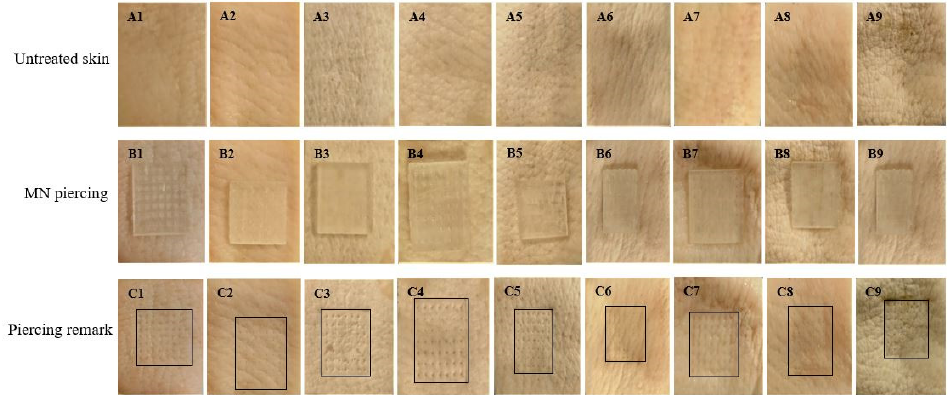
Figure 5. Digital photographs showing ( a ) untreated skin: A1–A9; ( b ) MN piercing: B1–B9; ( c ) pierc- ing remarks: C1–C9 for all MN